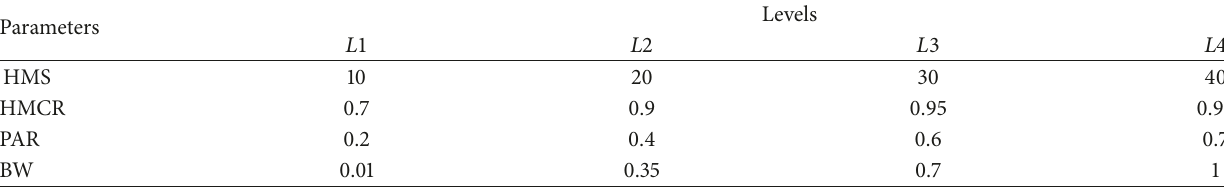
Table 1: Levels of parameters for